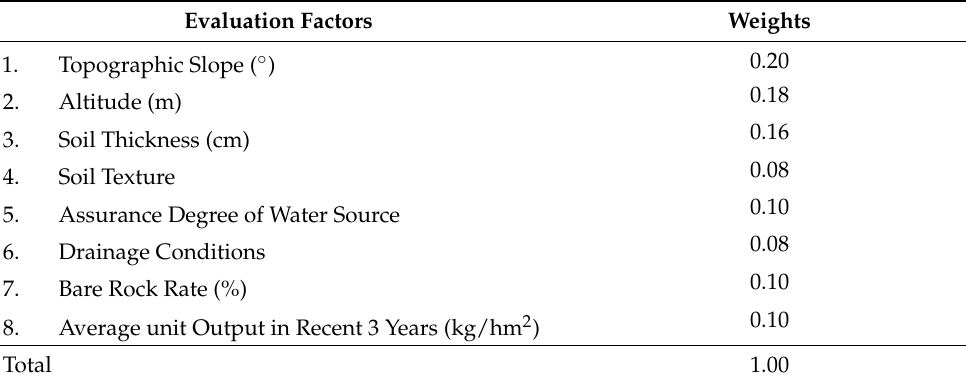
Table 3. Factors and weights for evaluating the land suitability of sorghum planting.